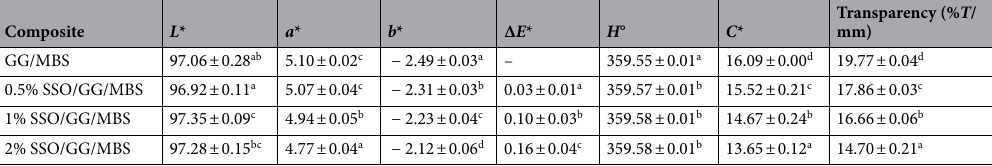
Table 2. Color values of GG/MBS and SSO/GG/MBS composite films. Data expressed as mean ± standard deviation of five replicates. Different lowercase letters (a–d) in the same column indicate a